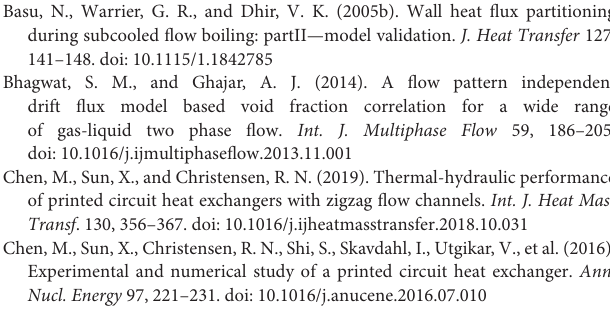
indicated in Figure 15 , shows that the relative error between model predicted results and experimental data is from − 60 to +